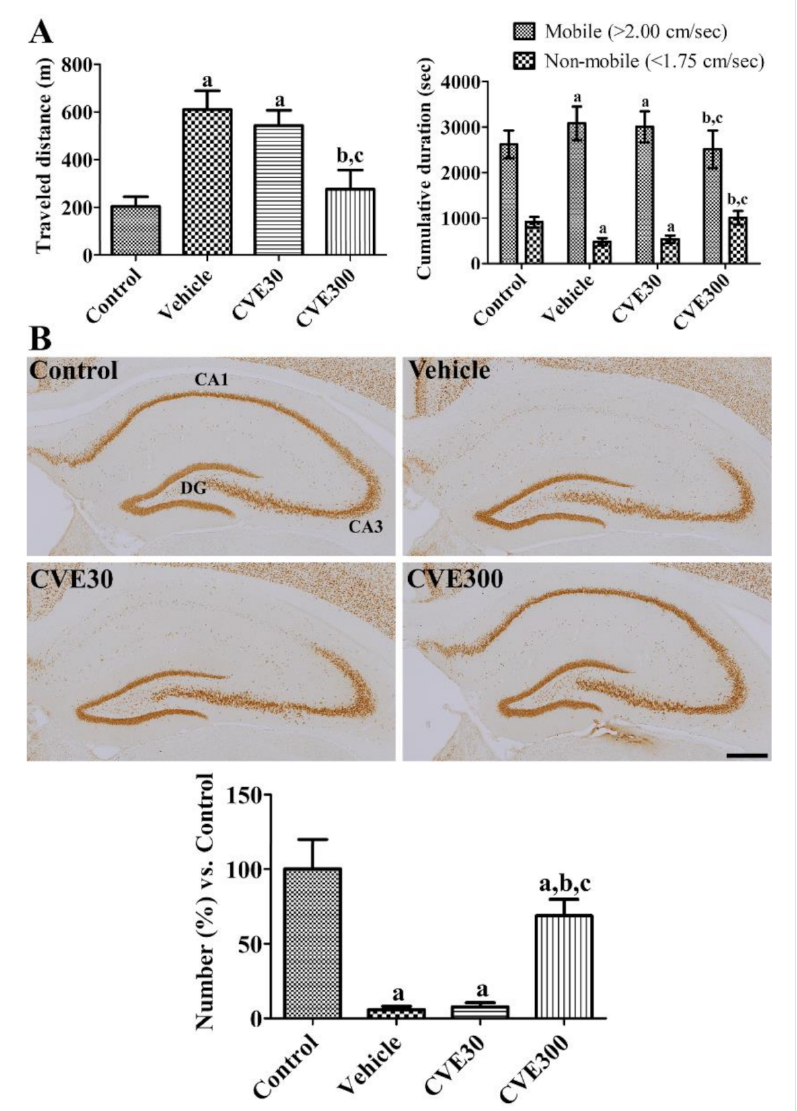
Figure 3. Cissus verticillata extract (CVE) ameliorates ischemia-induced hyperlocomotor activity and neuronal death in gerbils. ( A ) One day after ischemia, locomotor activity was analyzed based on travel distance and cumulative duration in sham-operated (control), ischemia-induced vehicle-treated (vehicle), ischemia-induced 30 mg/kg CVE-treated (CVE30), and ischemia-induced 300 mg/kg CVE- treated (CVE300) groups ( n = 10 per group). ( B ) Four days after ischemia, the hippocampi were immunostained with NeuN antibody to detect survived neurons. Scale bar = 400 µ m. The number of NeuN-immunoreactive neurons in the hippocampal CA1 region is presented as a percentile value compared to control group ( n = 5 per group). ( A , B ) Data are presented as mean value ± standard deviation and were analyzed using one-way ANOVA followed by Bonferroni’s post hoc test ( a p < 0.05, significantly different from the control group; b p < 0.05, significantly different from the vehicle group; c p < 0.05, significantly different from the CVE30